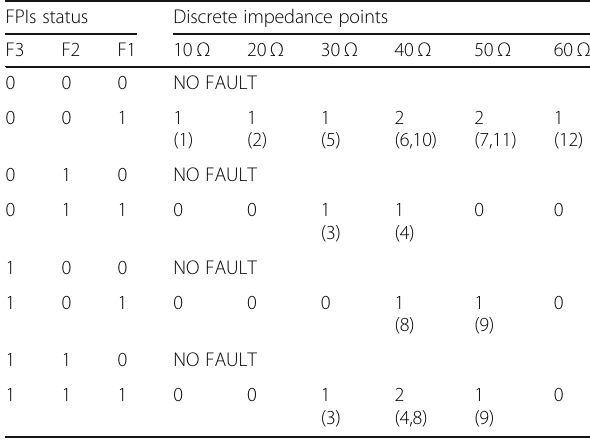
Table 2 FPIs flag status and corresponding discrete impedance points (suspected locations of fault) for Case 1 FPIs status